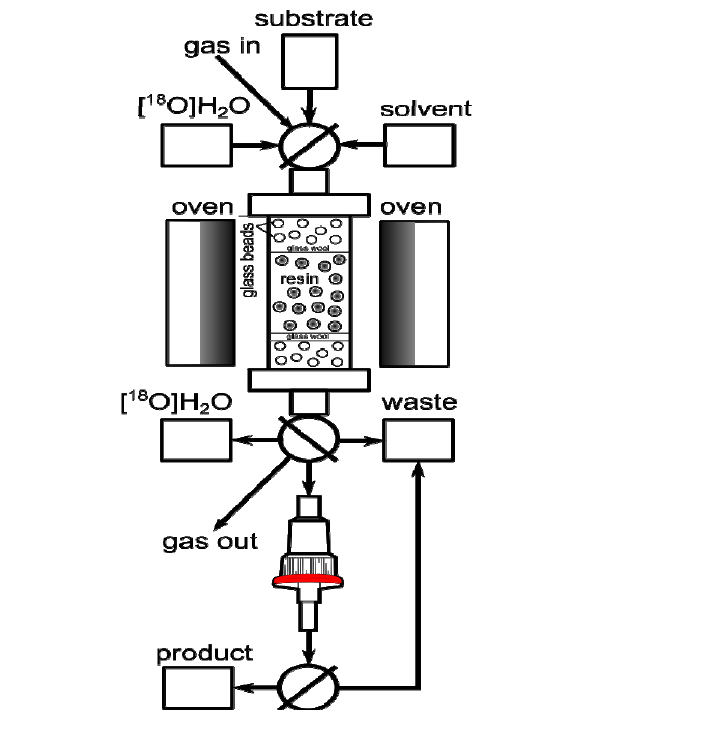
Figure 1. Automated radiosynthesis module for on-column